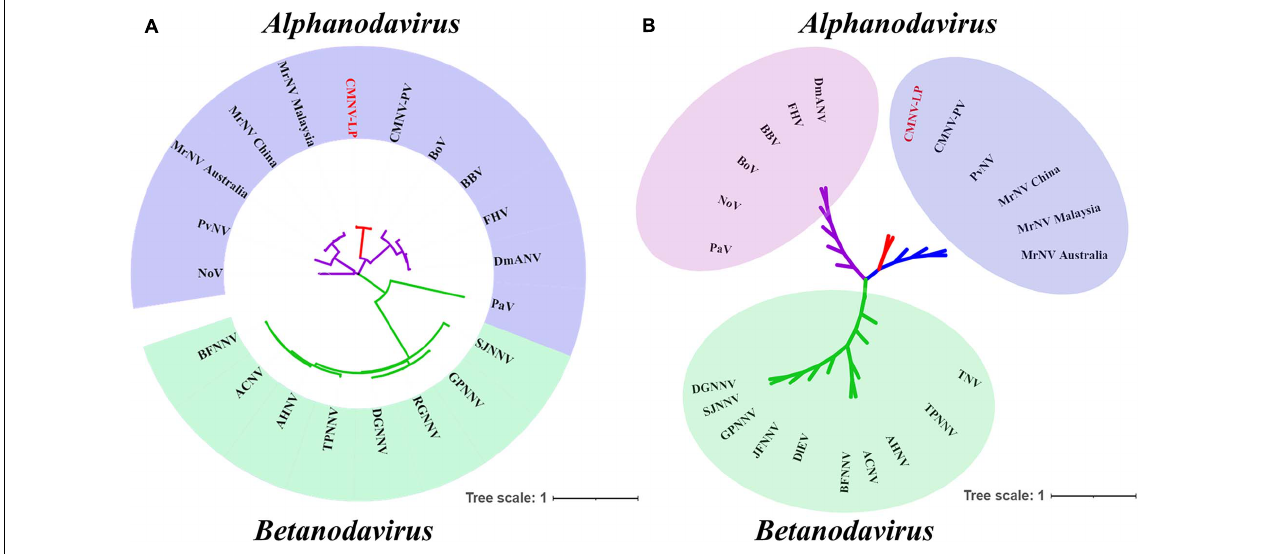
FIGURE 4 | Phylogenetic tree based on the deduced amino acid sequences of RNA-dependent RNA polymerase (RdRp) and capsid protein from different CMNV isolates and other nodaviruses (for virus abbreviations see Supplementary Table 1 ). (A) Phylogenetic tree based on the RdRp. (B) Phylogenetic tree based on the capsid protein. CMNV-LP, CMNV in Larimichthys polyactis. Bar represents branch length of one substitution per site.